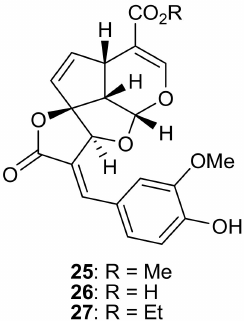
Figure 5. Structures of iridoids 25 – 27